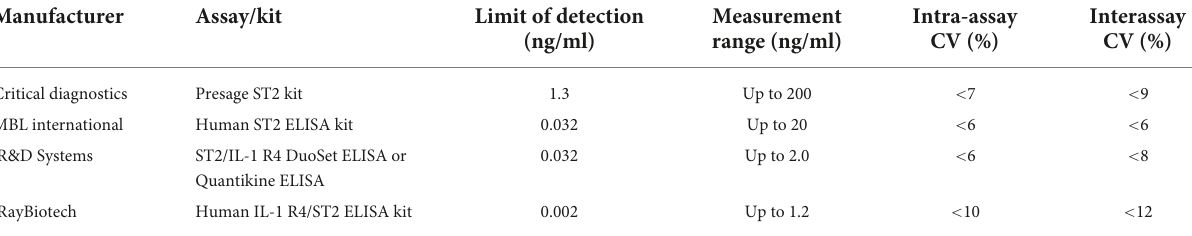
TABLE 4 Information on commercially available assay kits for measuring soluble growth stimulation expressed gene 2 (sST2) in human serum/plasma (91).